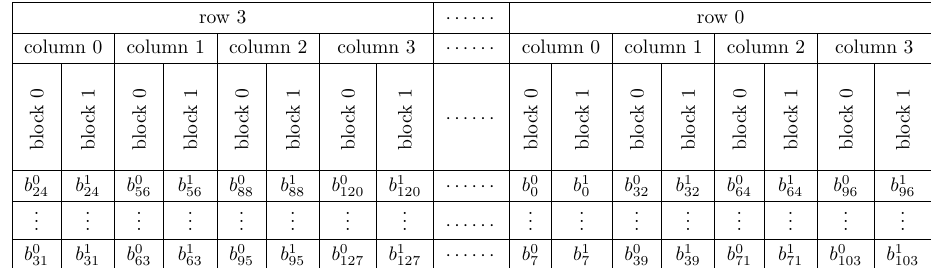
refers to the j -th bit of the i -th block. j